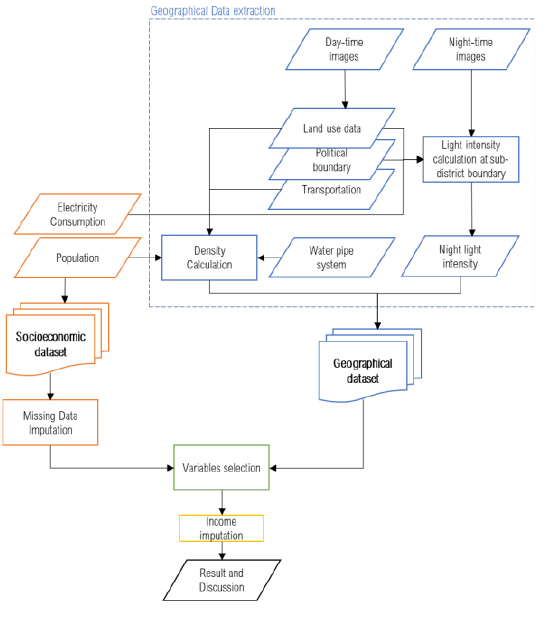
Figure 1. Research flowchart